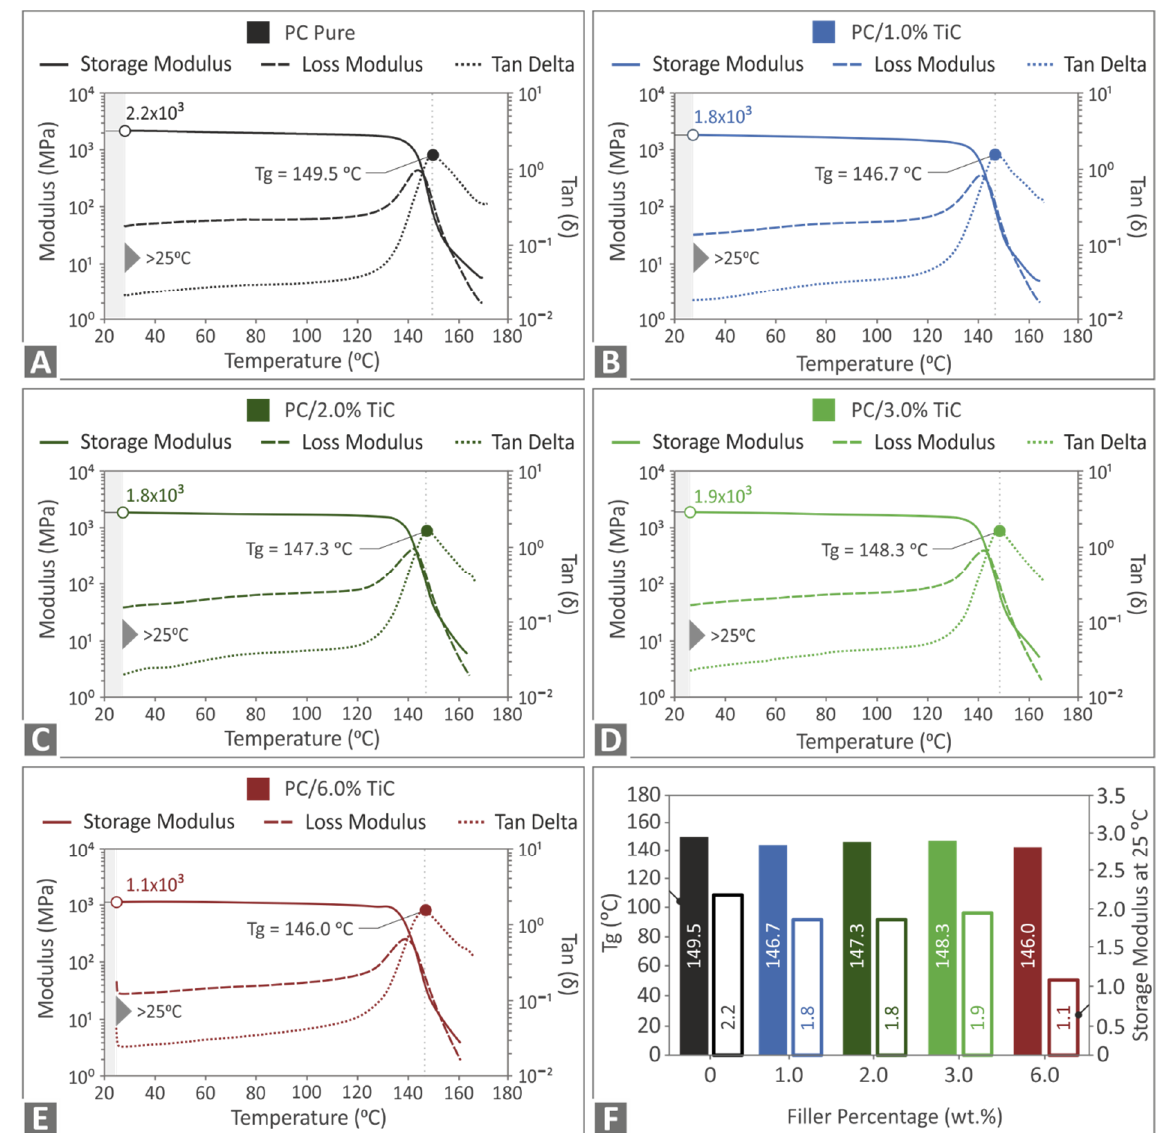
Figure 8. Storage modulus, loss modulus, and tan(delta) graphs for: ( A ) pure PC, ( B ) PC/TiC 1 wt.%, ( C ) PC/TiC 2 wt.%, ( D ) PC/TiC 3 wt.%, ( E ) PC/TiC 6 wt.%, and ( F ) glass transition temperature Tg (°C) and storage modulus values at 25 °C for all materials tested.